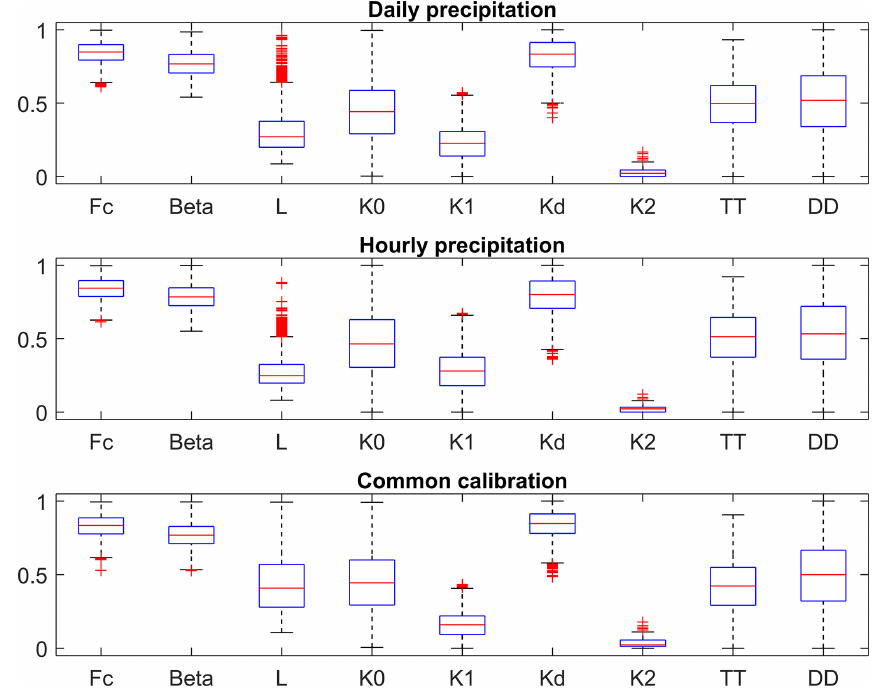
Figure 16. Comparison of model parameters for different temporal resolutions for Pforzheim